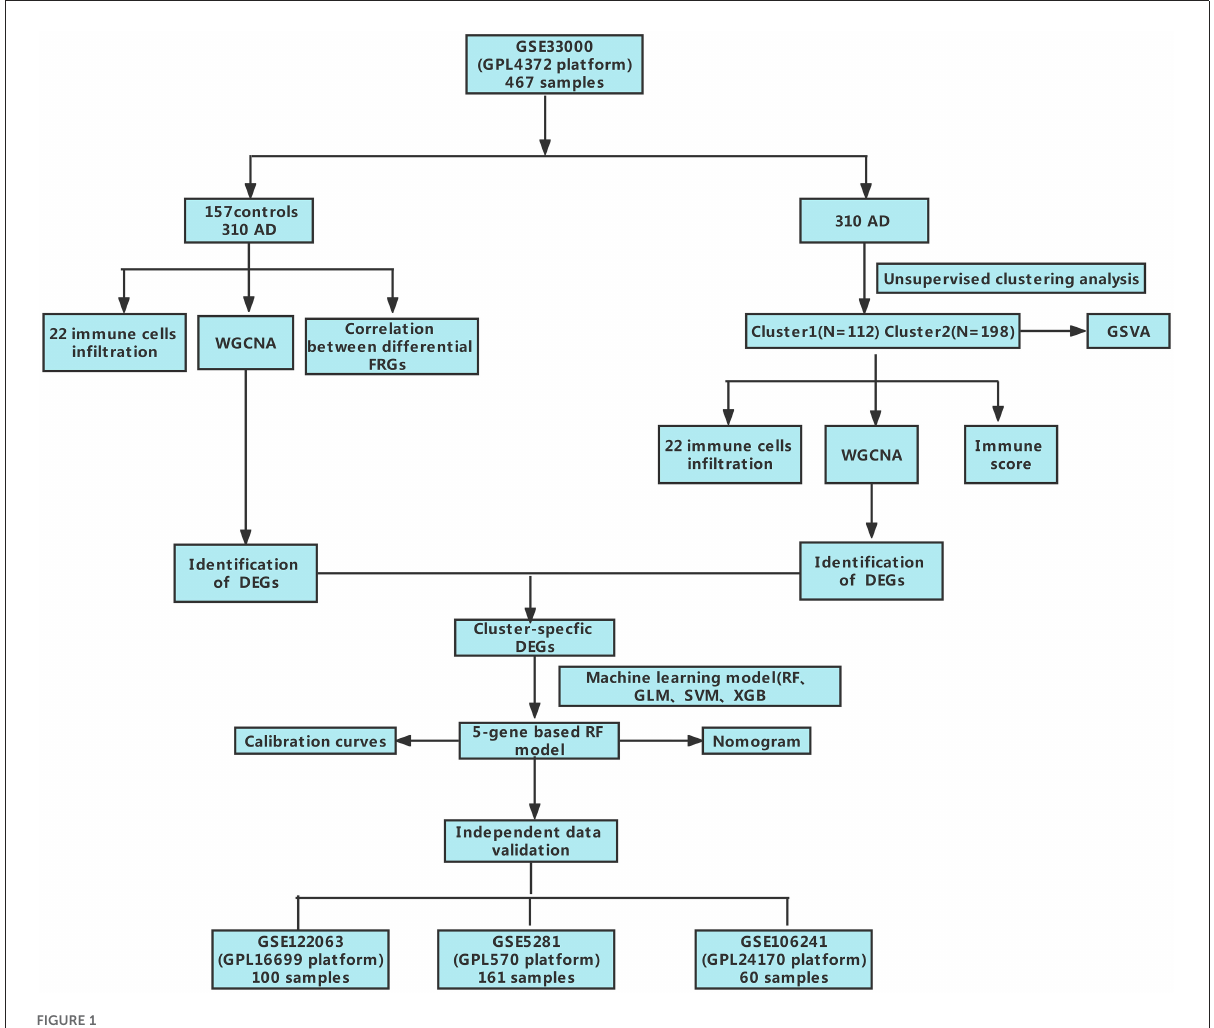
FIGURE1 The study flow